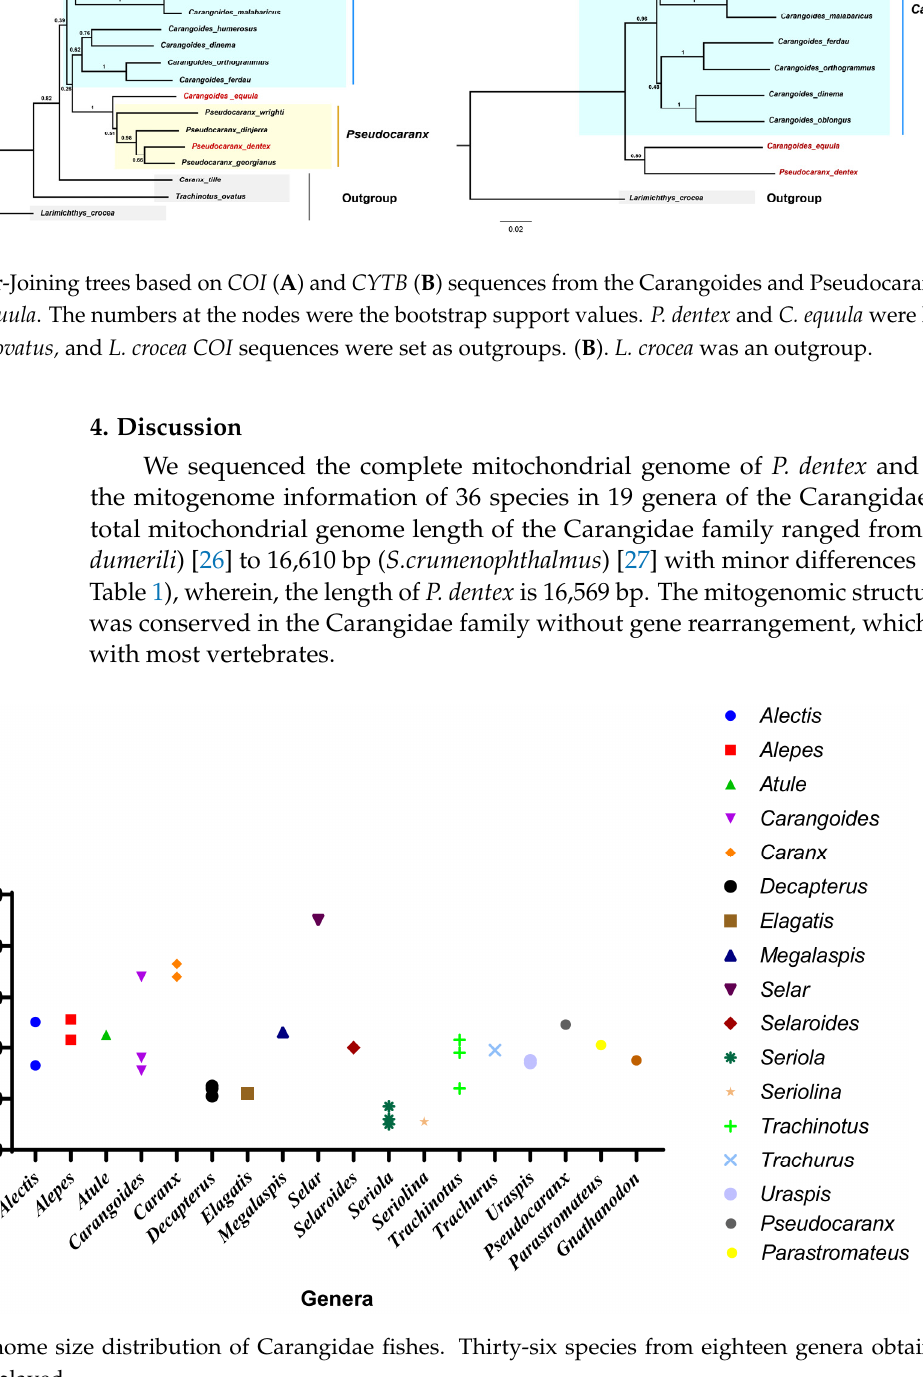
Figure 5. Phylogenetic tree of 36 species from the Carangidae family constructed by the maximum Likelihood method based on the concatenated sequences of 13 PCGs. L. crocea was set as an out- group. The bootstrap support values were displayed on the branches. The species in red ( P. dentex ) was generated in the present study. Trachinotiae, Naucratinae, and Caranginae subfamilies were labeled in blue, purple, and green, respectively.